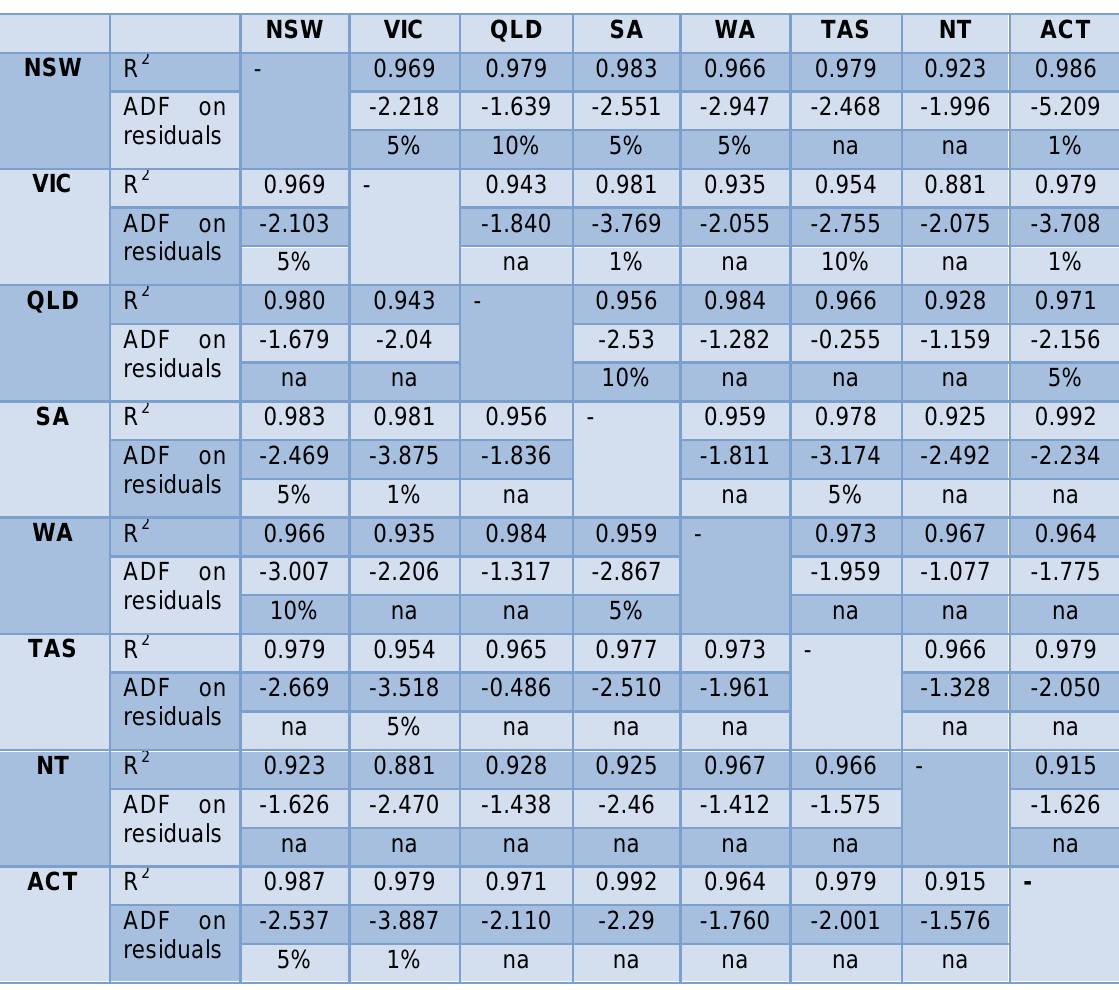
Table 2 Pairwise co-integration test results (without deterministic trend) Note: The percentage number in the ADF on residuals row denotes the significance level when the null hypothesis is rejected